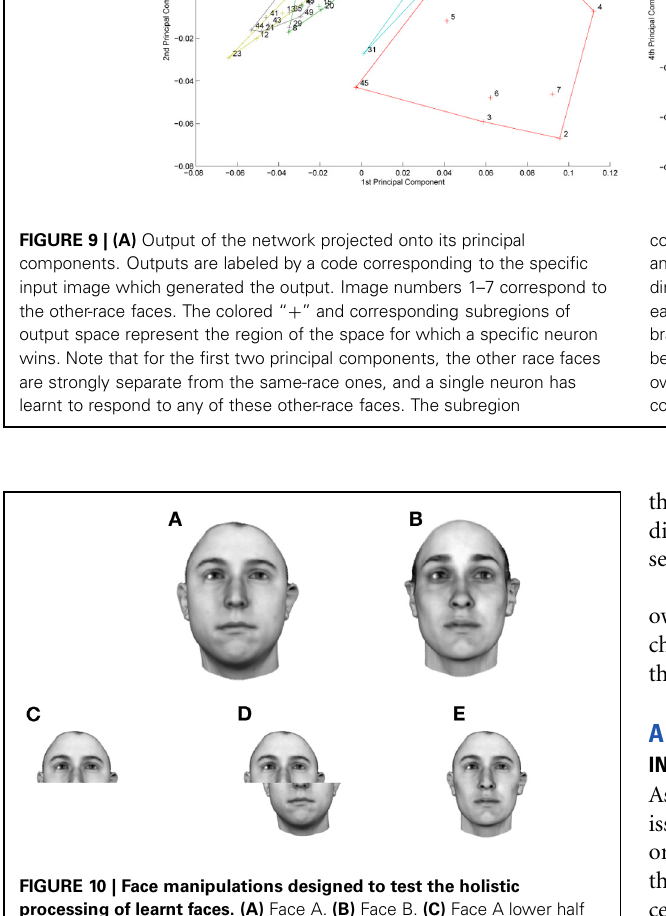
FIGURE 10 | Face manipulations designed to test the holistic processing of learnt faces. (A) Face A. (B) Face B. (C) Face A lower half deleted. (D) Face A, lower half horizontally offset. (E) Face A with the lower half replaced with the lower half of Face